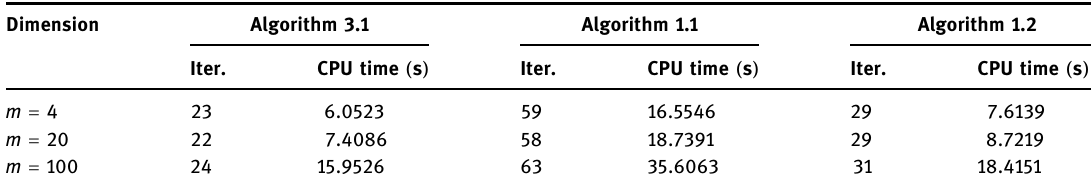
Algorithm 3.1 Algorithm 1.1 Algorithm 1.2